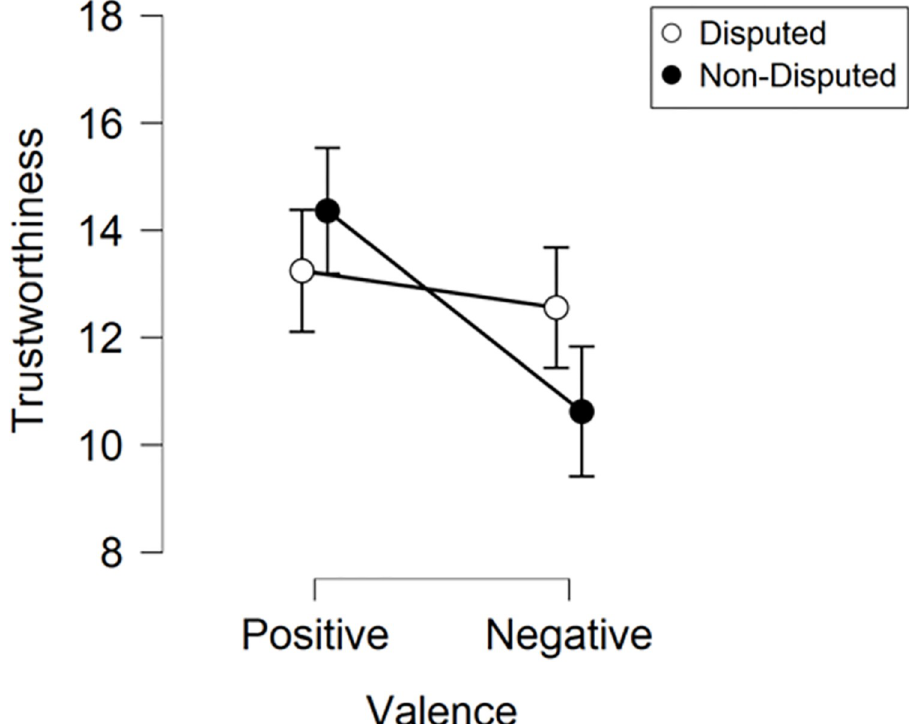
Fig 2. Experiment 1 ratings. Trustworthiness ratings obtained during the test phase of Experiment 1. Error bars depict ± SEM.